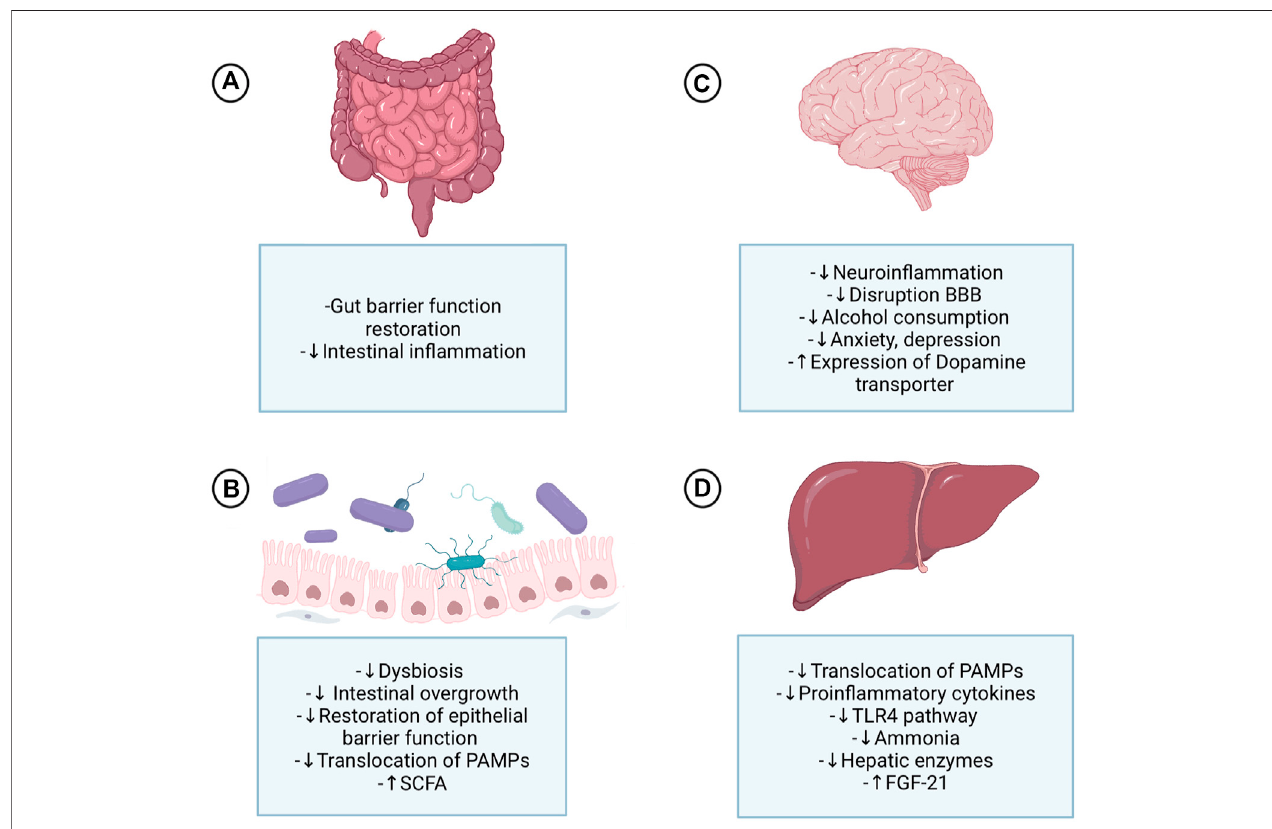
FIGURE 2 | Probiotics ’ effect on the gut-microbiota-liver-brain axis in ALD. Probiotics exert their actions at different levels of the gut-microbiota-liver-brain axis, acting directly on each of these organs and indirectly due to the axis component ’ s interplay. (A) At the intestinal level, probiotics improve digestion and tight junction ’ s expression and are a protective factor for the crypts and mucous layer. (B) The change enhances the effects that probiotics produce in the microbiota, restoring it and decreasing dysbiosis triggered by alcohol abuse, which will lead to a decrease in harmful bacteria and an increase in bene fi cial ones, therefore reducing the high permeabilityofthegutandthetranslocationofPAMPstotheliver. (C) Probiotics ’ effectinthebraincausesadecreaseinproin fl ammatorycytokinesatthesystemiclevel; consequently,thesystemandneuroin fl ammationareattenuatedbyaprobiotic-basedtherapy.In fl ammationcontrolisoneofthemechanismsbehindcontrollingalcohol consumption and psychological symptoms, such as anxiety and depression. Furthermore, the control of high permeability and the translocation of substances contributestocontrollingthedisruptionoftheblood-brainbarrierandneuroin fl ammation.Finally,FGF21hasanimportanteffectonthebrainsinceitproducesdopamine transporter transcription in the nucleus accumbens, allowing less dopamine to access the postsynaptic receptor. (D) Probiotics have demonstrated multiple bene fi ts at the liver level since the decrease of steatosis to encephalopathy and cirrhosis. These liver effects are explained by the decrease of PAMPs in the systemic circulation, especially LPS, that induce the normalization of the in fl ammatory processes that are associated, among others, with the TLR4 pathway. Consequently, the adverse effects of alcohol on the liver are decreased; less activation of Küpffer cells, decreased liver enzymes, proin fl ammatory cytokines, and less fi brosis. Some probiotics cause increased formation of FGF21 in the liver, which has effects on the brain. ALD: Alcoholic liver disease; SCFA: Short-chain fatty acids; PAMPs: Pathogen- associated molecular patterns; BBB: Blood-brain barrier; TLR4: Toll-like receptor 4; FGF21: fi broblast activation protein 21.